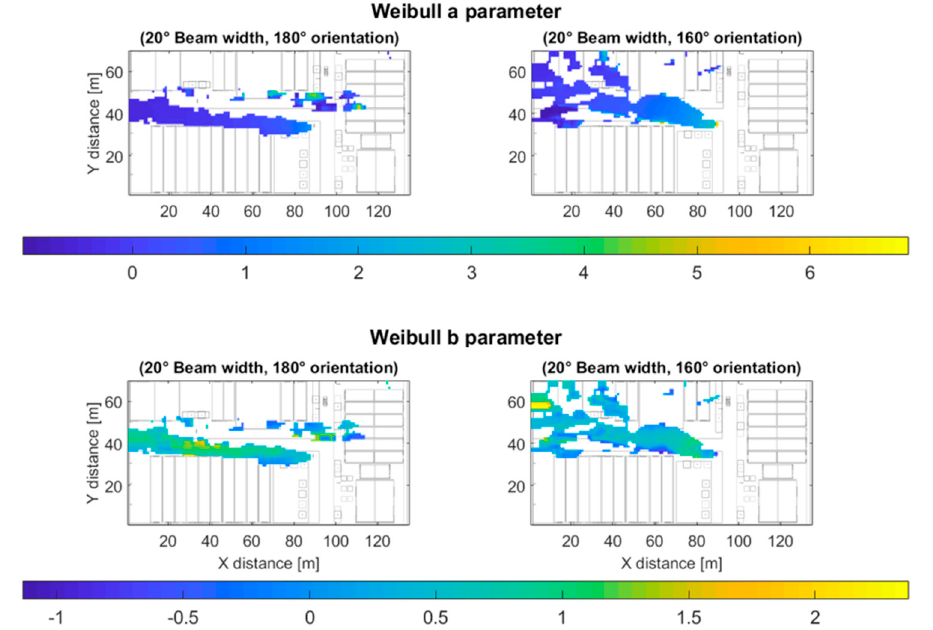
Figure 13. Weibull distribution’s 𝑎 ( top ) and 𝑏 ( bottom ) parameters for the 20° beam width outdoor scenarios.